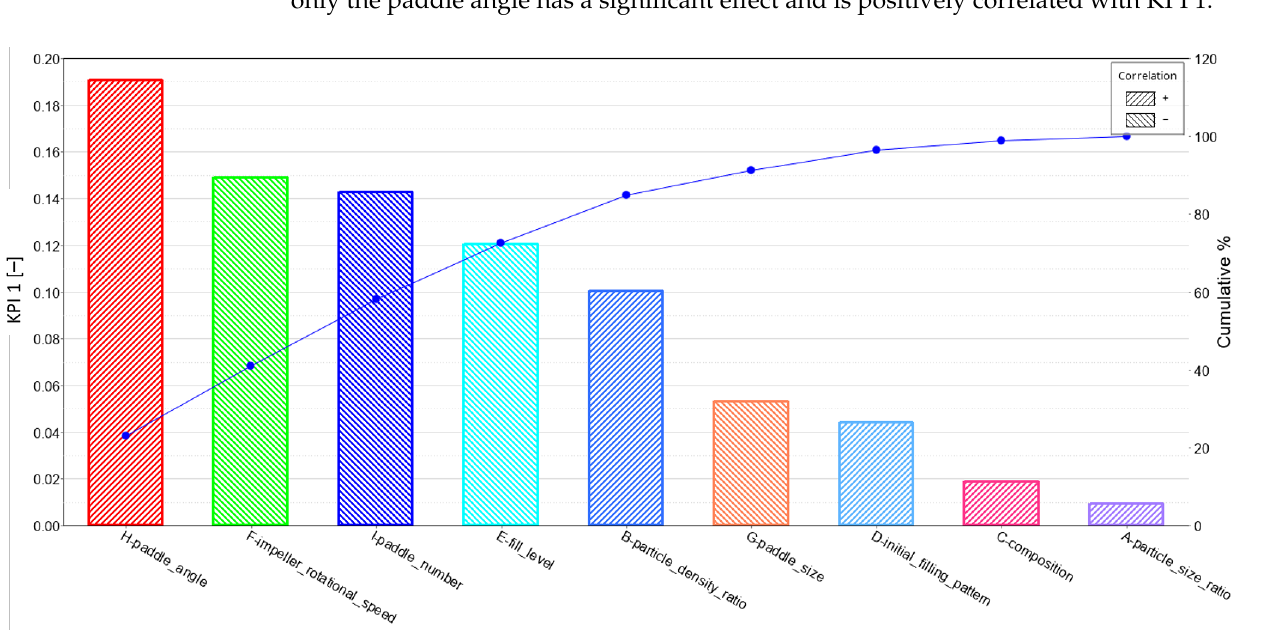
Figure 6. The Pareto plot of KPI 1 mixing quality. Table 6. Analysis of variance (ANOVA) results of KPI 1 mixing